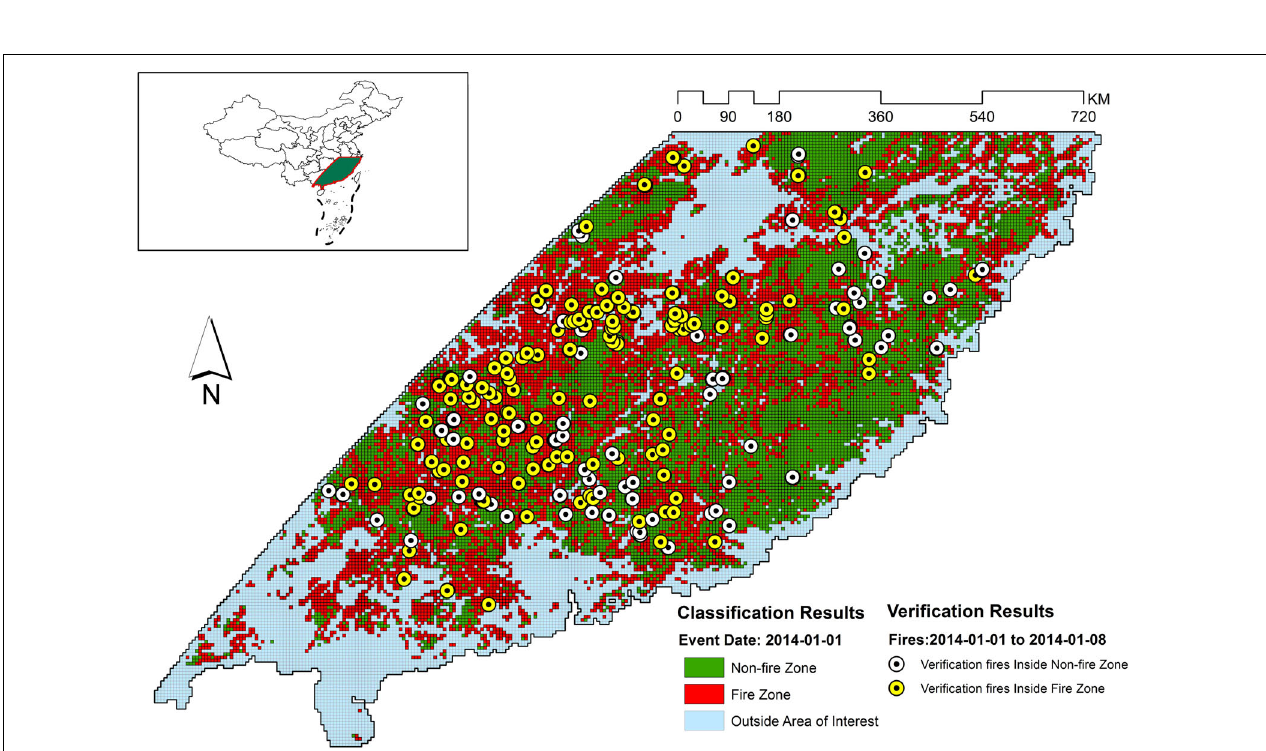
FIGURE 6 | Classification and verification results for